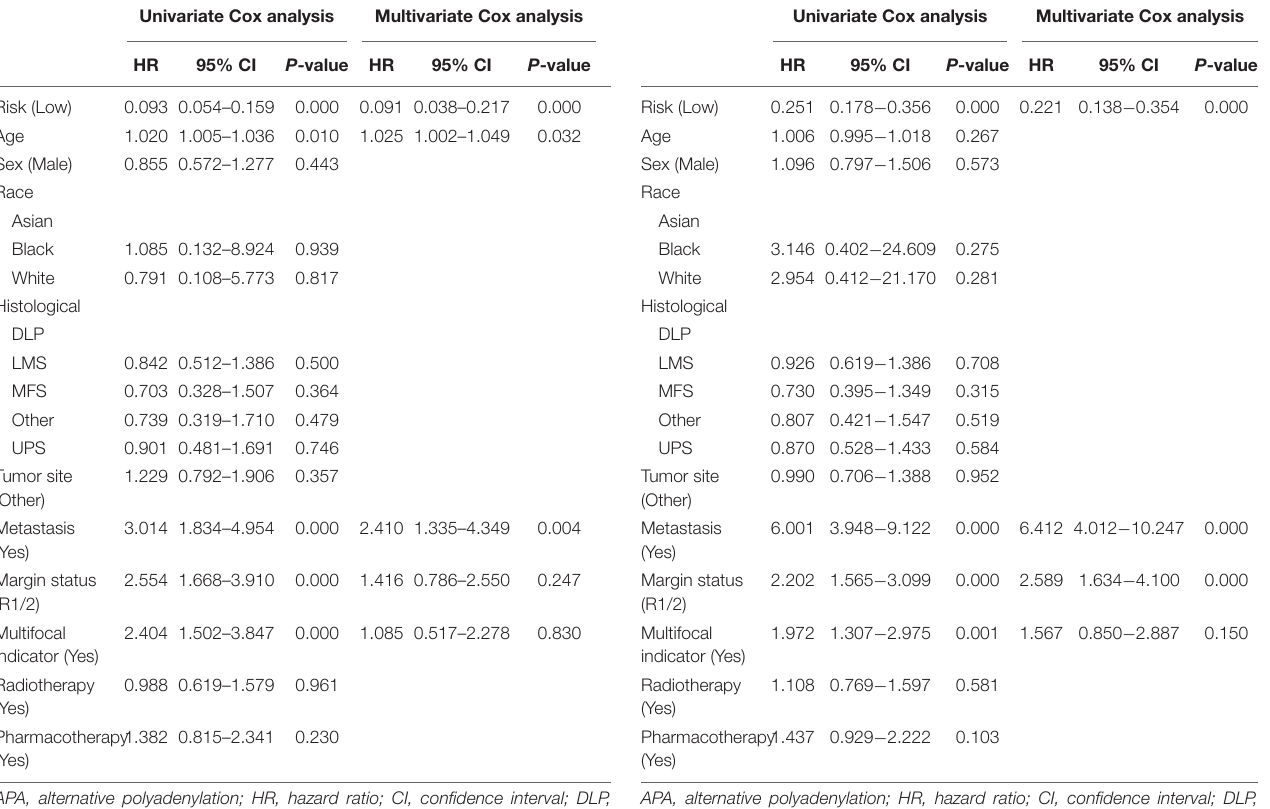
TABLE 1 | Overall survival analysis of APA signature and clinical data for sarcoma.